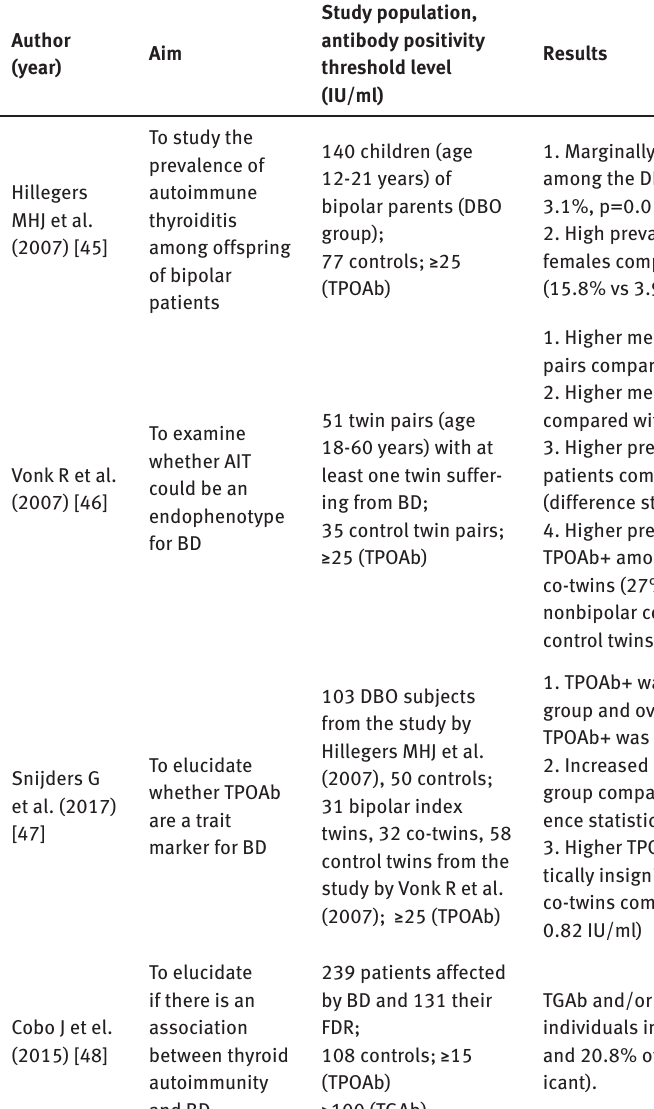
Table 4: Studies assessing the link between thyroid autoimmunity and bipolar disorder